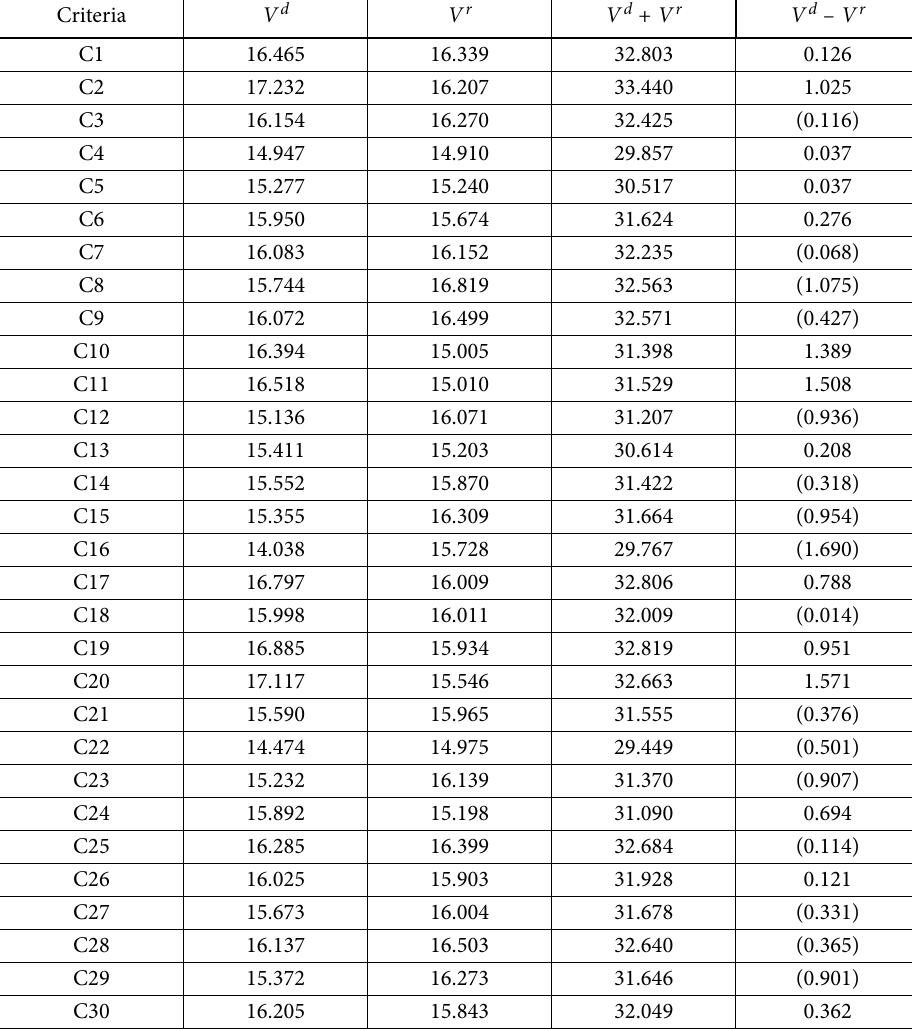
Table 7. Sum of influences given and received on the SCP criteria Criteria